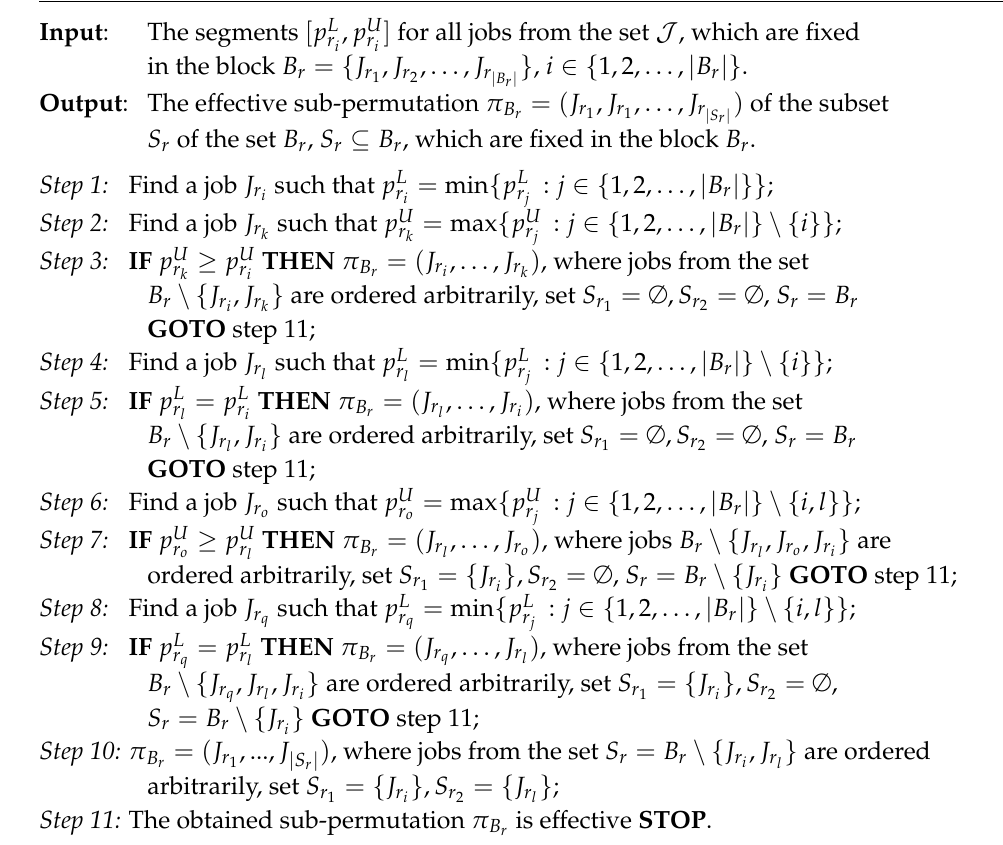
Algorithm 2: Construction of the effective permutation of the jobs fixed in the block B